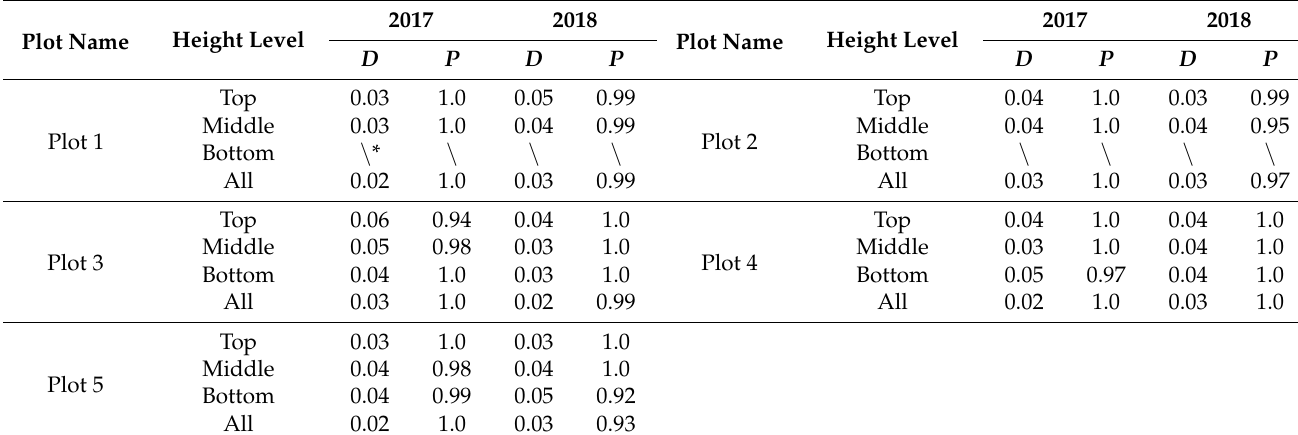
Table 4. The results of the Kolmogorov–Smirnov test comparing the manual and quasi-automatic measurements of needle inclination angle measurements in the five plots. D and P are the maximum difference between the cumulative distributions ( D ) and the corresponding level of probability ( P